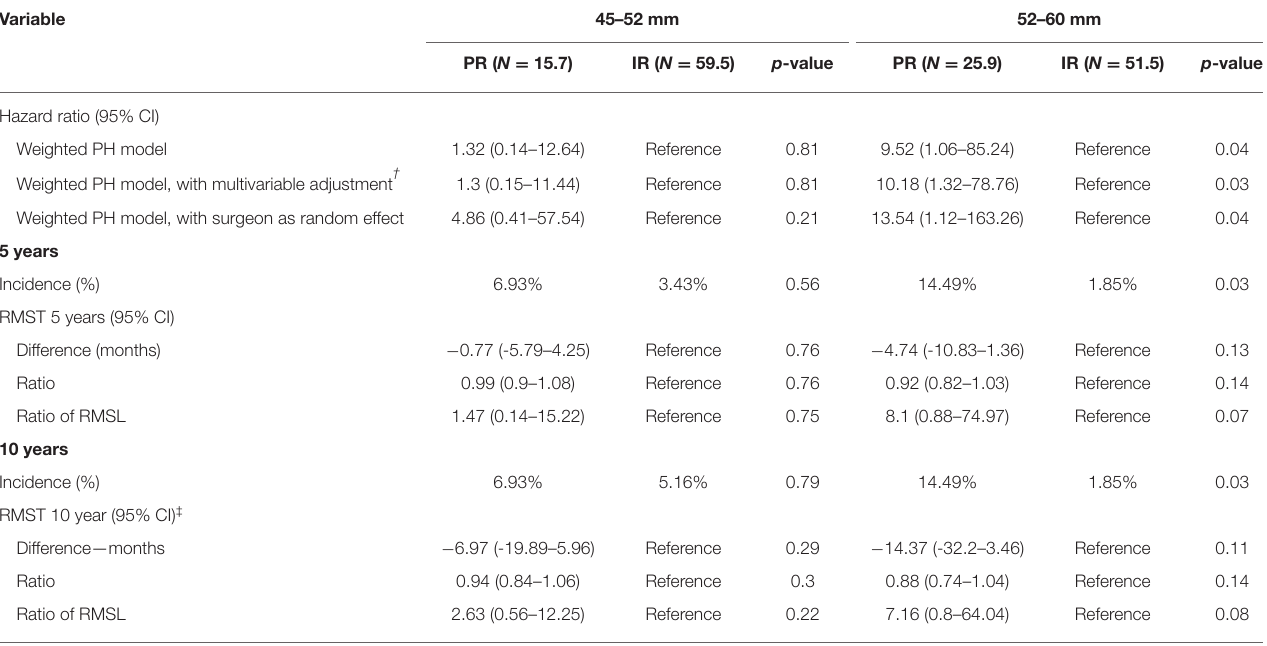
TABLE 3 | Diameter-group differences in primary endpoints in “aorta type*.”